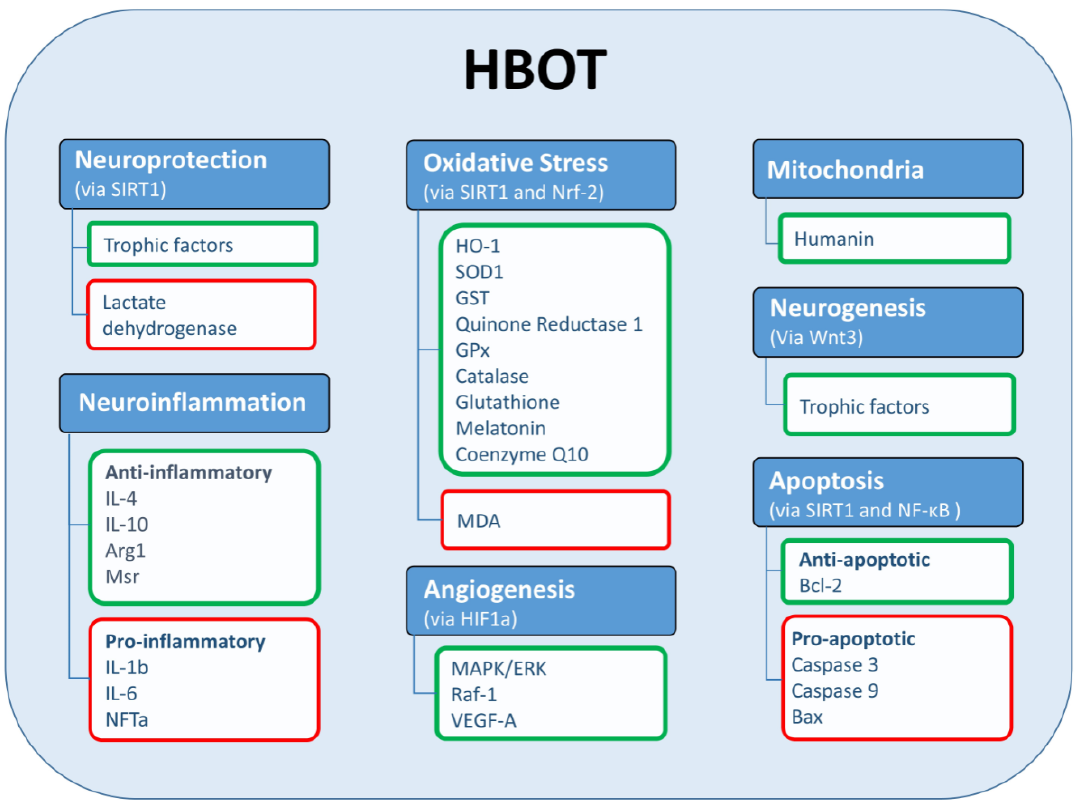
Figure 2. HBOT affects multiple cellular and molecular pathways. HBOT affects several molecular and cellular pathways that are important for cellular and neuronal recovery including neuroprotection via SIRT1, oxidative stress via SIRT1 and Nrf-2, apoptosis via SIRT1, neurogenesis via Wnt3. Green frames represent proteins and processes that are upregulated; red frames represent proteins and processes that are downregulated. Abbreviations: nuclear factor erythroid 2-related factor 2 (Nrf-2), nuclear factor kappa B (NF- κ B), Hypoxia-Inducible Factor 1-alpha (HIF1a), heme oxygenase 1 (HO-1), superoxide dismutase 1 (SOD1), malondialdehyde (MDA), B-cell lymphoma 2 (Bcl2), Bcl-2-associated X protein (Bax), vascular endothelial growth factor (VEGF-A), Glutathione-S-transferases (GST), Glutathione Peroxidase (GPx), tumor necrosis factor alpha (TNFa), Wnt Family Member 3 (Wnt3).